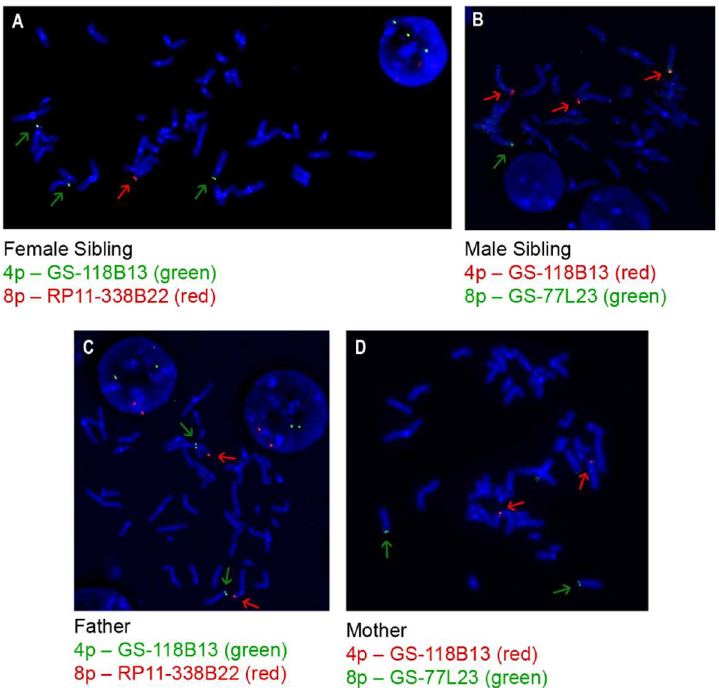
Fig 2. FISH images. (A) image showingthat, in the female sibling,there were three chr4p copies, marked in green with a GS-118B13 probe (green arrow), and one chr8p copy, marked in red with a RP11-338B22 probe (red arrow); (B) image showingthat, in the male sibling,there were also three chr4p copies, marked in red with a GS-118B13 probe (red arrow), and one chr8p copy, marked in green with a GS-77L23 probe (green arrow); (C) image showingthat, in the father, there was a balancedtranslocation,t(4;8); and (D) image showingthat, in the mother, the chromosomes were normal. disease enrichment analysis (S3 Table) revealed that 5 genes (WHSC1 , FGFR3 , SH3BP2 , LETM1 , and STX18 ) were found to be overrepresented in craniofacial abnormalities (adjusted p -value = 0.0002), musculoskeletal abnormalities (adjusted p -value = 0.0009) and congenital abnormalities (adjusted p-value = 0.0040). Other genes, such as GAK , HTT , TMEM175 , FAM193A , and DGKQ , were mainly related to movement disorders (adjusted p -value = 0.0001) and basal ganglia disease (adjusted p -value = 3.73e-05). The gene ontol- ogy analysis revealed enrichment of fibroblast growth factor-activated receptor activity ( FGFR3 and FGFRL1 genes, adjusted p -value = 0.0082) and rough endoplasmic reticulum ( NAT8L , LRPAP1 , and HGFAC genes, adjusted p -value = 0.0445). The 8p23.1 deletion affects 6 brain-expressed genes (from a total of 8 RefSeq genes accord- ing to the hg19 build from the UCSC Genome Browser): RPL23AP53 , ZNF596 , FAM87A , FBXO25 , TDRP , and ERICH1 . As expected, there was no significant functional enrichment. Using the STRING, we searched possible connections described in the literature and pro- tein-protein interaction databases connecting all the CNV genes. There were 61 genes repre- sented in the STRING (S2 Fig), with 32 connected proteins (i.e., 52.45%, 32/61) and 29 interactions, representing enrichment of interactions ( p -value = 3.09e-14). In addition, genes overrepresented in craniofacial abnormalities, musculoskeletal abnormalities, syndromic abnormalities, or congenital abnormalities were all presented in the biggest component of the network formed (the component with the most number of connecting genes). The genes